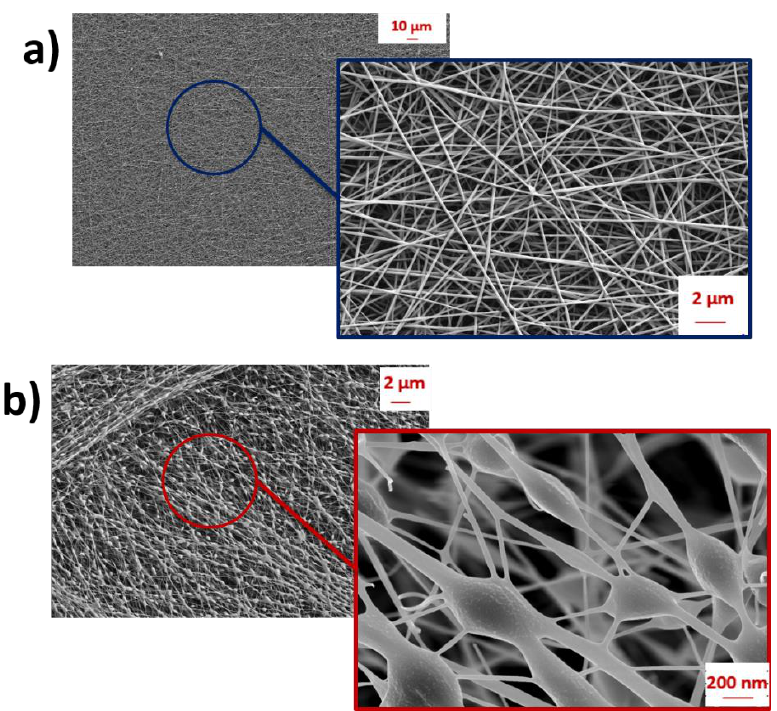
Figure 1. ( a ) FESEM images representing the uniform distribution of PEO-NFs onto carbon-based material without defects, as beads, drops, occurred during the electrospinning process. In the blue box, the ordered distribution of PEO-NFs onto the conductive CP is highlighted; ( b ) FESEM images reporting the presence of microorganisms directly encapsulated into nanofiber mats.